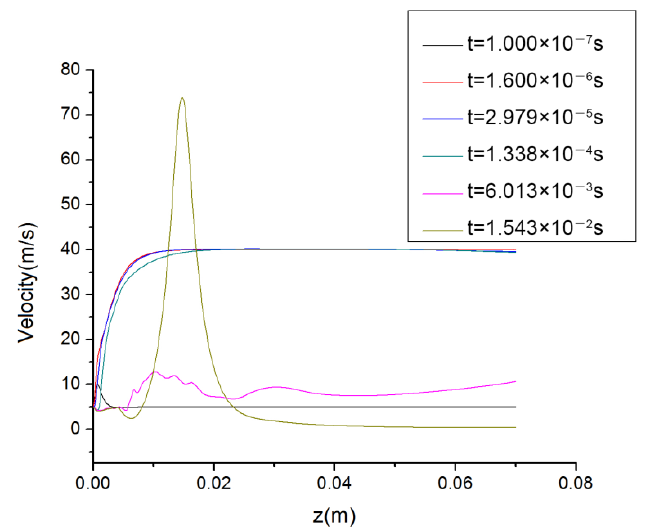
Figure 9. Variation of velocity on spinning line with time.